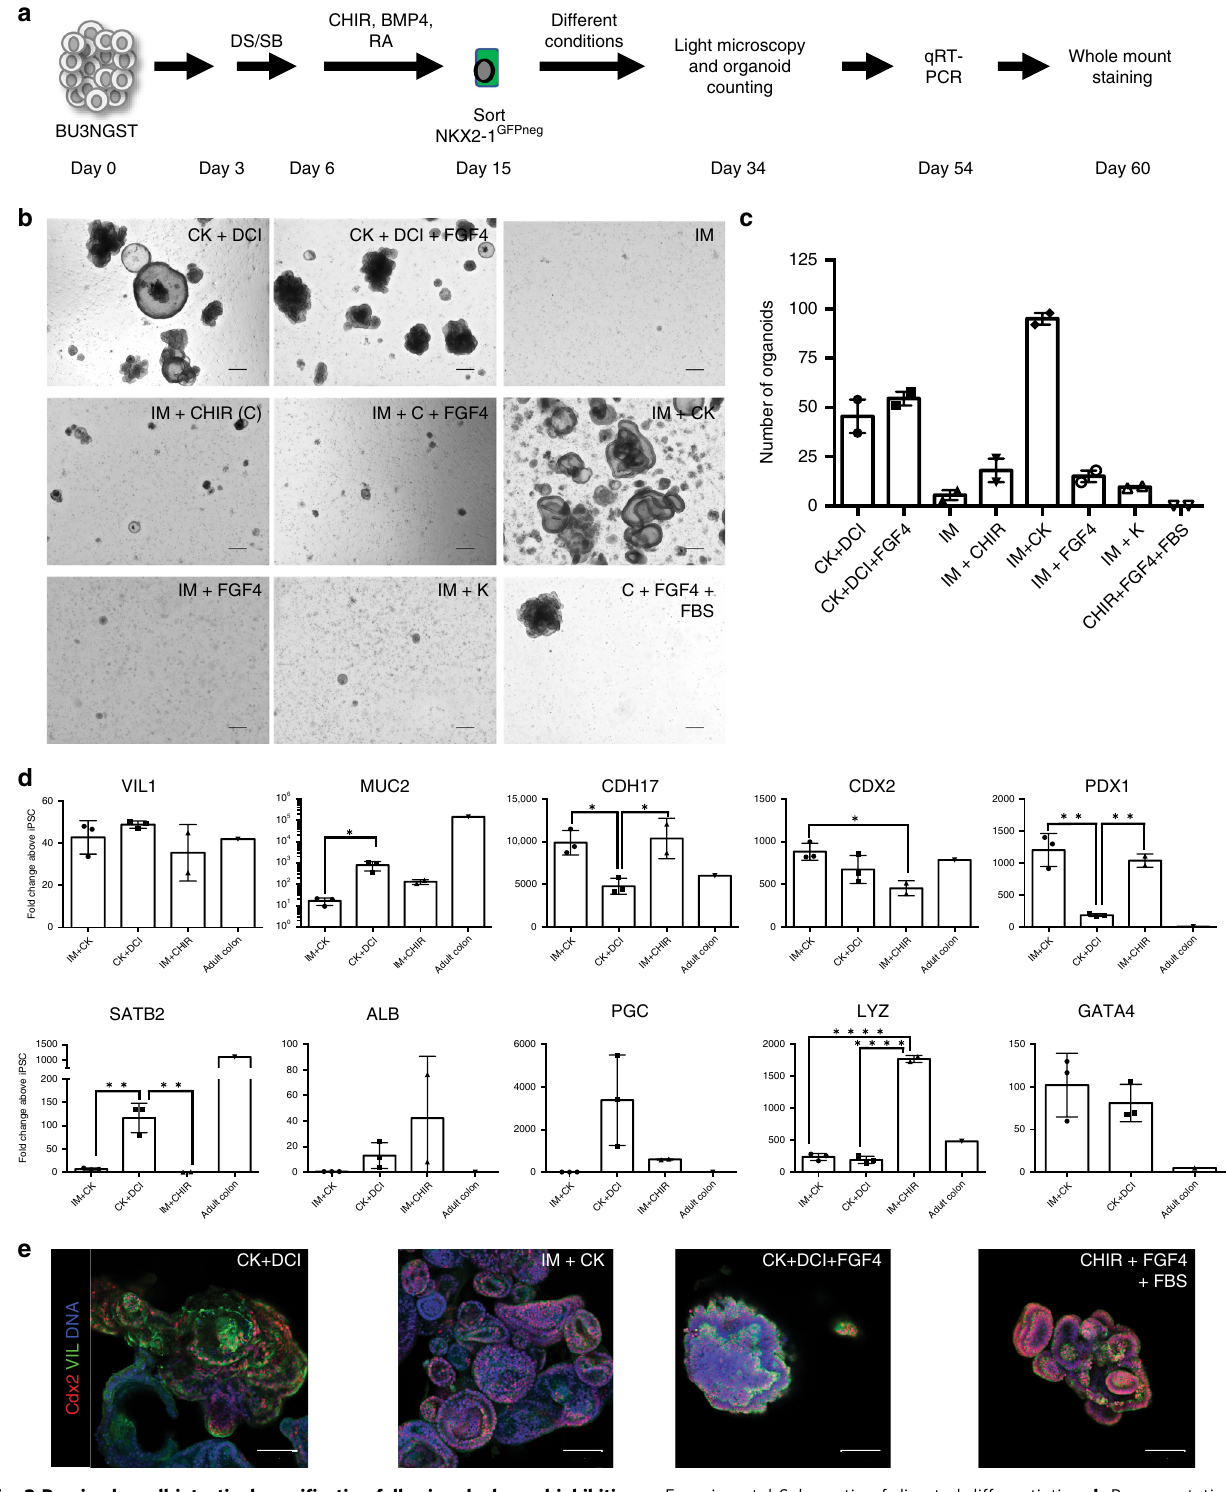
Fig. 3 Proximal small intestinal speci fi cation following dual-smad inhibition. a Experimental Schematic of directed differentiation. b Representative micrographs of cells grown in different media conditions at day 34 of differentiation after sorting for NKX2-1 GFP negative cells at day 15 (scale bar = 300 μ m, representative of n = 2 independent wells per condition). c Quanti fi cation of number of organoids per well at day 50 in different culture conditions. Error bars represent s.e.m. from n = 2 independent wells per condition. d qRT-PCR from day 54 HIOs cultured in either IM + CK, CK + DCI, or IM + CHIR normalized to day 0 hiPSCs and compared with a primary control (human adult colon) (2 − ΔΔ CT , technical triplicates normalized to GAPDH or ACTB ( β - ACTIN), n = 3 independent differentiations except IM + CHIR (IM + C, n = 2 independent differentiations). Error bars represent the s.d., statistical signi fi cance, where indicated, determined by one way-ANOVA followed by Tukey test, * p < 0.05, ** p < 0.005, **** p < 0.0001). e Whole mount immuno fl uorescence of day 60 organoids stained for Villin (VIL), Cdx2 and DNA (blue) (scale bar = 100 μ m, representative of n = 3